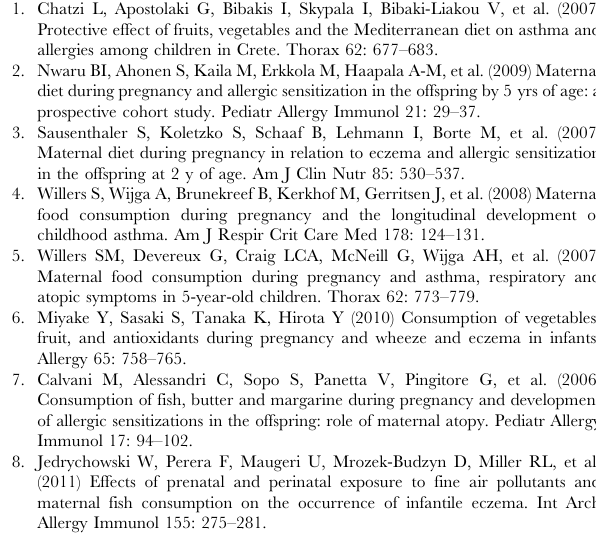
Table S1 Associations between sugar-sweetened non- carbonated soft drinks consumption during pregnancy and child asthma in the Danish National Birth Cohort. Table S2 Associations between sugar-sweetened car- bonated soft drink consumption during pregnancy and child asthma in the Danish National Birth Cohort. Table S3 Associations between sugar-sweetened car- bonated and non-carbonated soft drinks consumption during pregnancy and self-reported ever child allergic rhinitis in the Danish National Birth